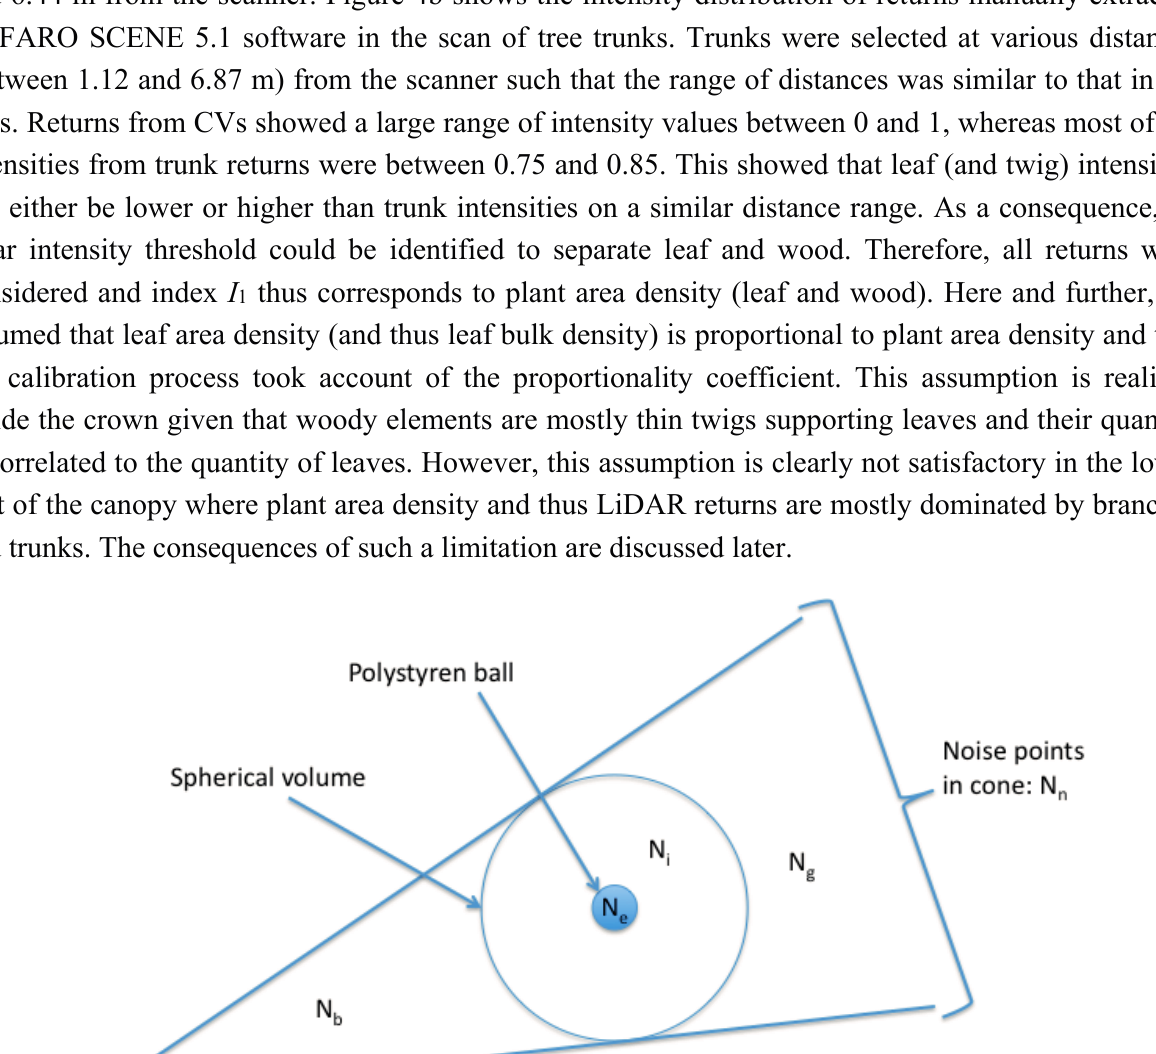
( N b ), the returns from the polystyrene ball ( N e ), the returns from vegetation “inside”